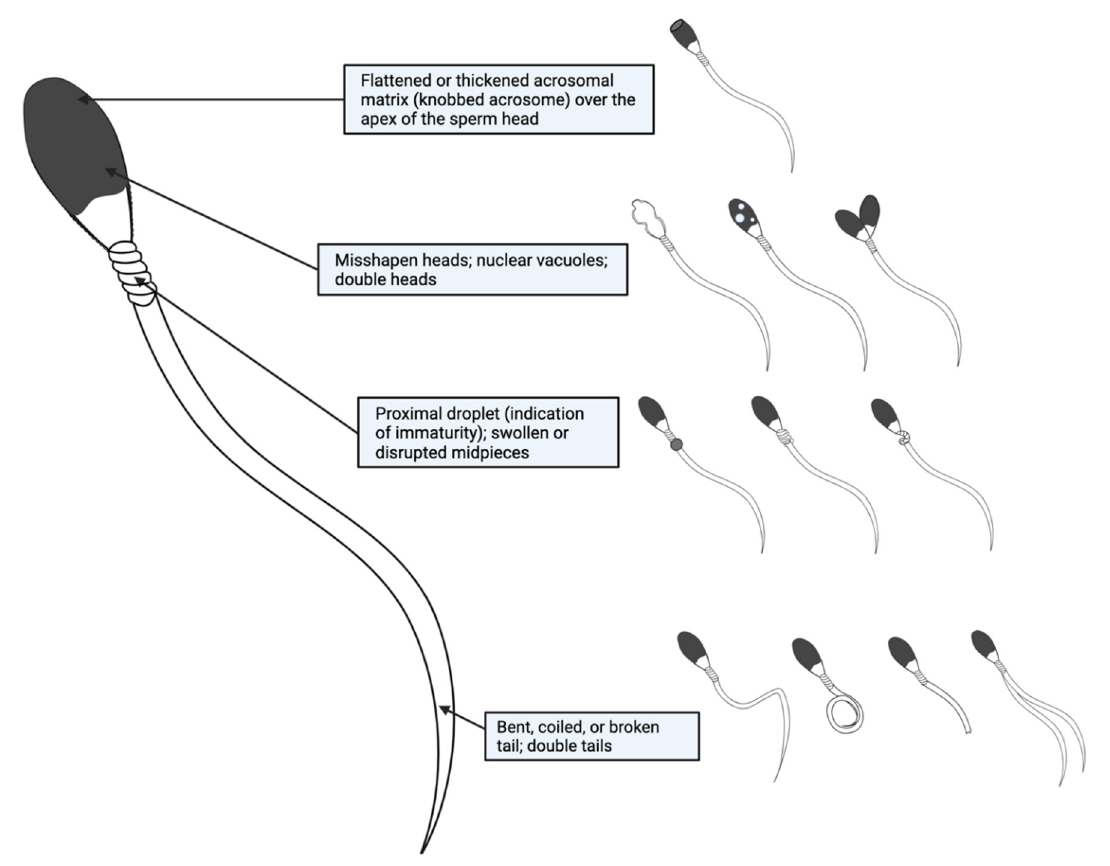
Figure 3. Common abnormalities of equine spermatozoa. Visualizable sperm abnormalities can be broken down by anatomical region: acrosome, head, midpiece, and tail.